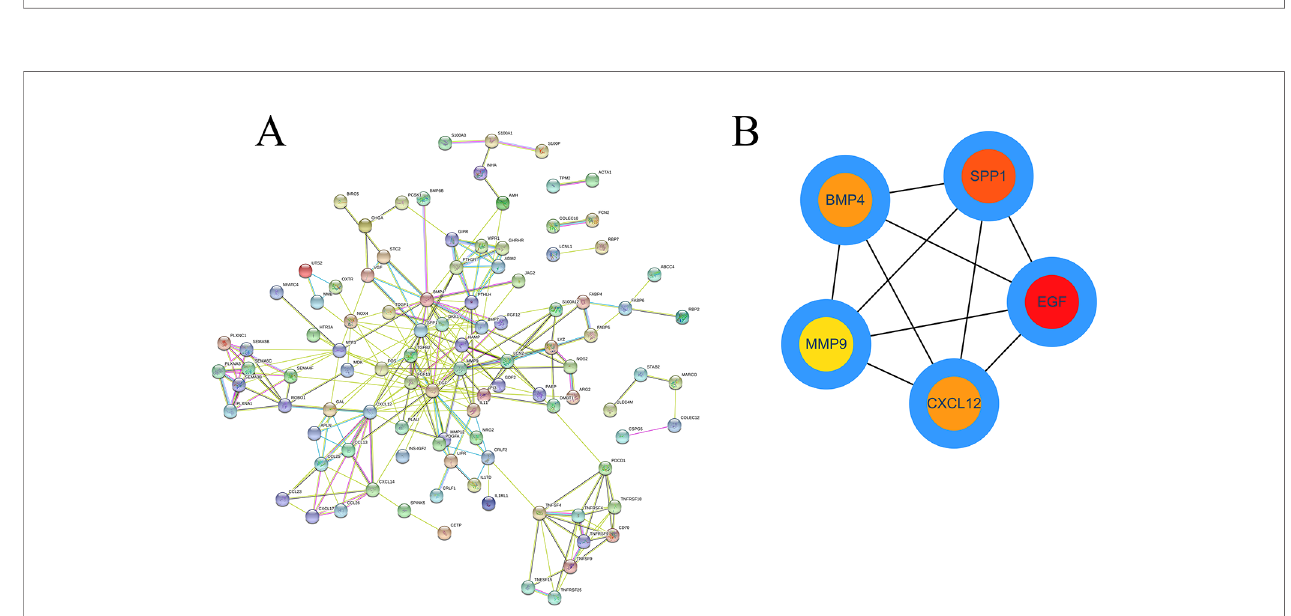
FIGURE 8 | The PPI network of DEIRGs. (A) DEIRGs and (B) hub